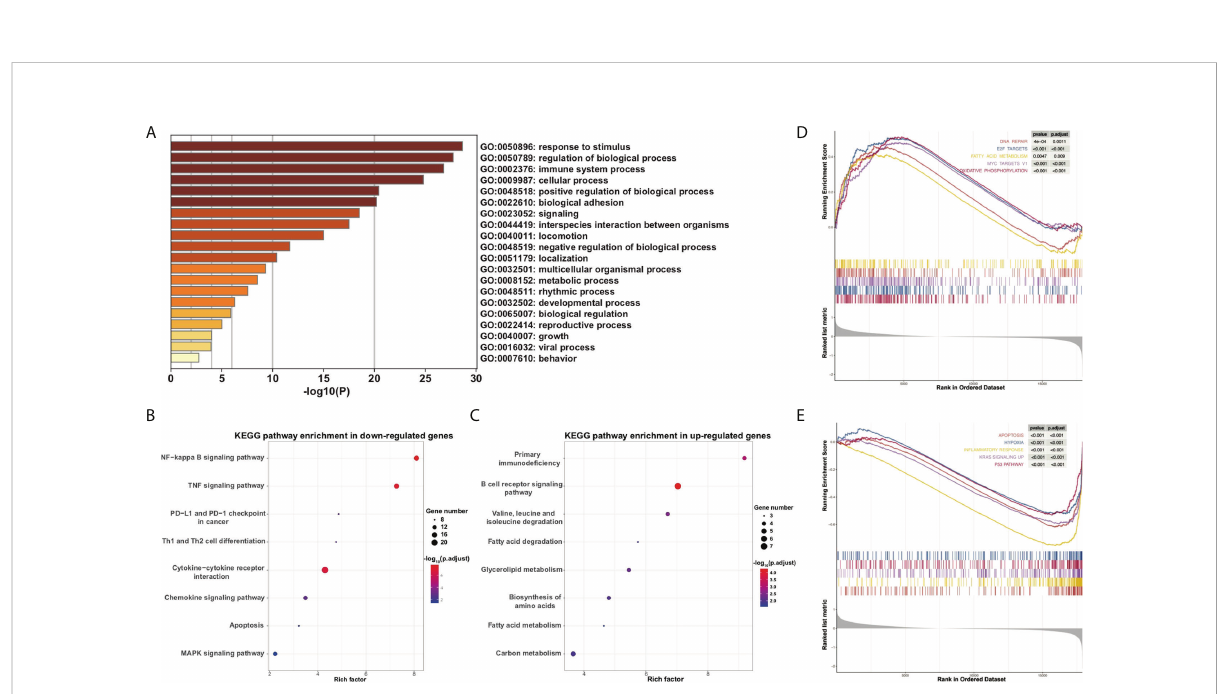
FIGURE 6 Functional analysis of DEGs between high- and low-risk subgroups. (A) Barplot for GO analysis of DEGs based on the Metascape online. (B, C) Bubbles plot for KEGG pathways of downregulated and upregulated DEGs. (D, E) GSEA between high- and low-risk